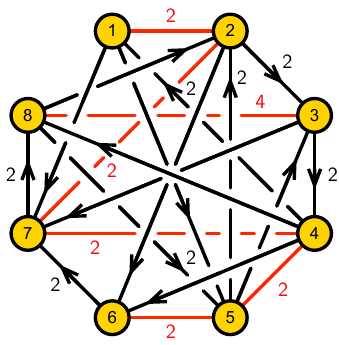
Figure 8 . Quiver for Y 2 , 1 ( CP 1 × CP 1 )